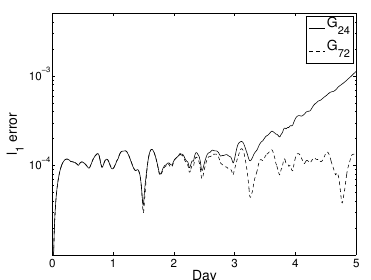
Figure 17. Numerical results of relative vorticity for unbalanced setup of barotropic instability test on a series of refined grids. Con- tour lines vary from − 1 . 1 × 10 − 4 to − 0 . 1 × 10 − 4 by dashed lines and 0 . 1 × 10 − 4 to 1 . 5 × 10 − 4 by solid